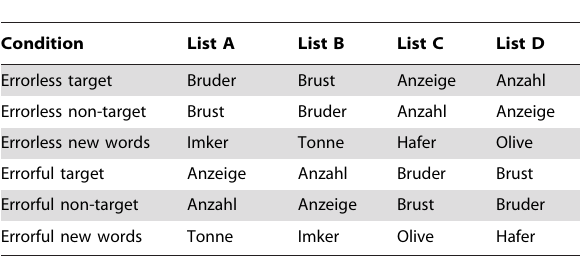
Table 2. Example of stimuli